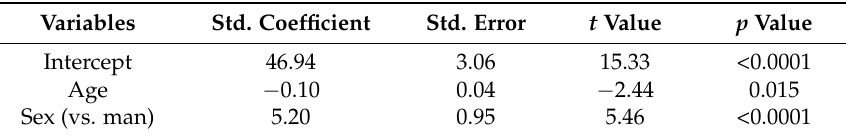
Table 4. Significant factors affecting L3 SMI by multiple linear regression